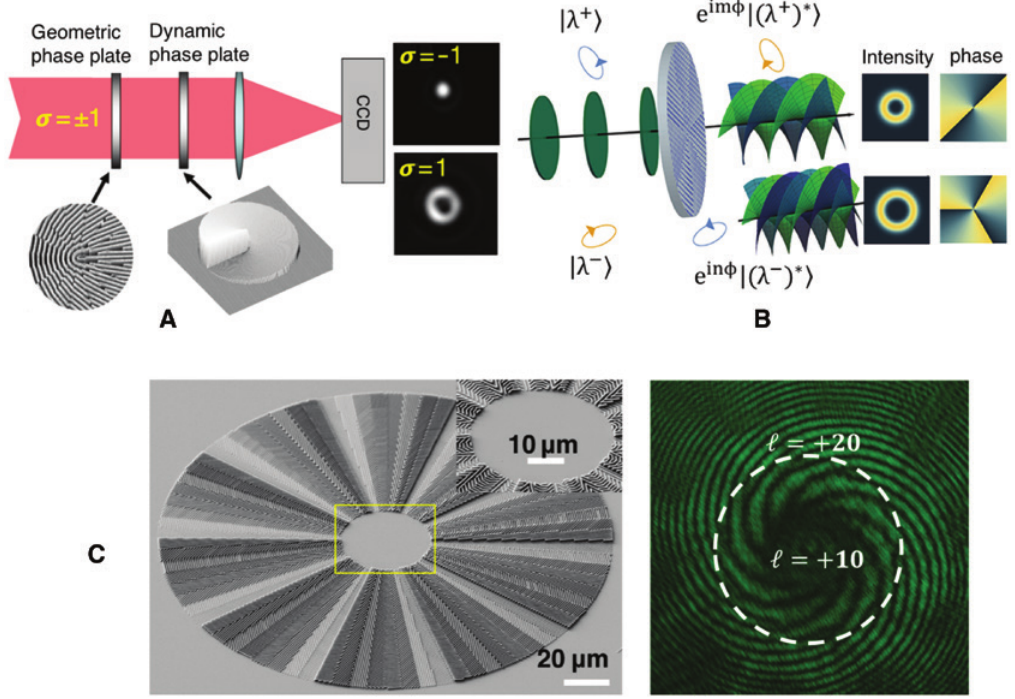
Figure 6: Independent spin-orbital angular momentum conversion by hybrid phase plate. (A) Schematic illustration of independent spin-orbital angular momentum conversion of a pair of spin states passing a system consisted by geometric phase and dynamic phase plates. Reprinted from Ref. [155]. (B) Illustration of a hybrid metasurface plate for arbitrary OAM generation. Reprinted from Ref. [156]. (C) A hybrid dielectric metasurface plate fabricated by femtosecond laser printing generates ℓ = 10 for spin value σ = –1 and ℓ = 20 for spin value σ = 1 simultaneously when illuminated by a linear polarized light. Reprinted from Ref.